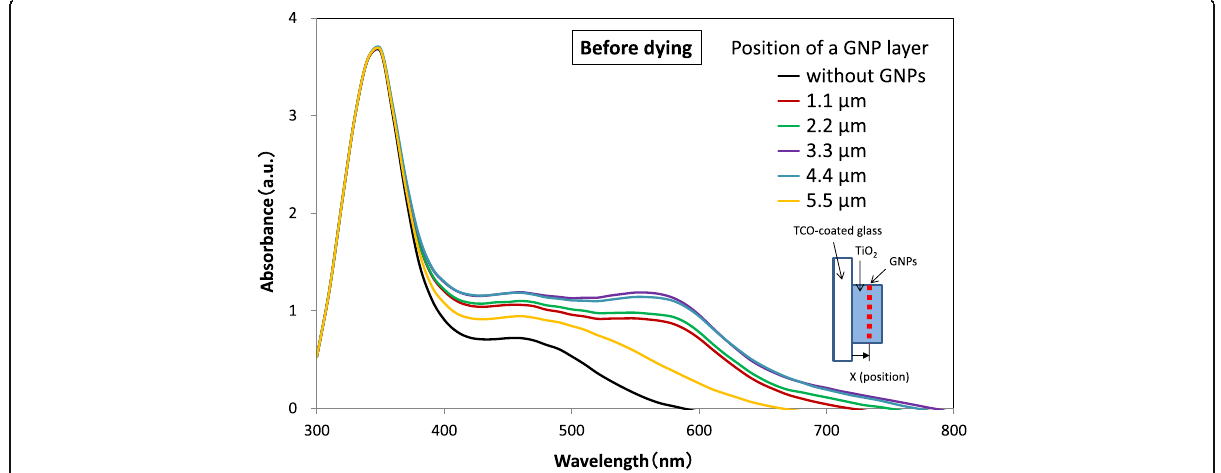
Fig. 5 Absorbance spectra of TiO 2 layers with varying the position of a GNP layer. The density of GNPs is 2.7 μ g/cm 2